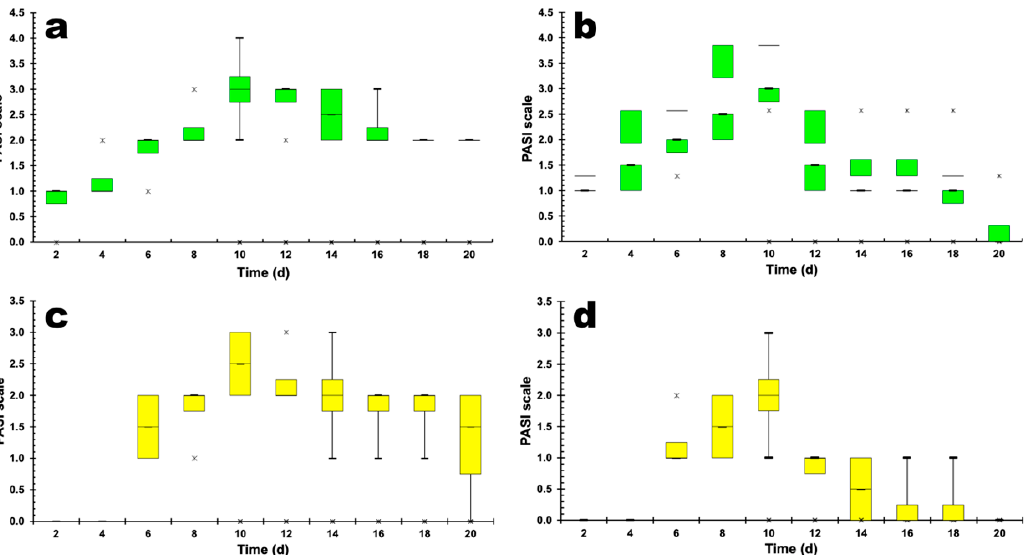
Figure 7. Boxplot graphs of the evolution of erythema ( a , b ) and ear skin peeling ( c , d ) in male ( a , c ) ( p < 0.001) and female ( b , d ) ( p < 0.001) mice. Legend: (*) represent outlier points off the average values. Figure 8 presents the results obtained for the evolution of erythema and ear skin peel ‐ ing induced by imiquimod (IMQ) and the comparison of the remission obtained via ap ‐ plication of the treatments with the LBG gel formulations.